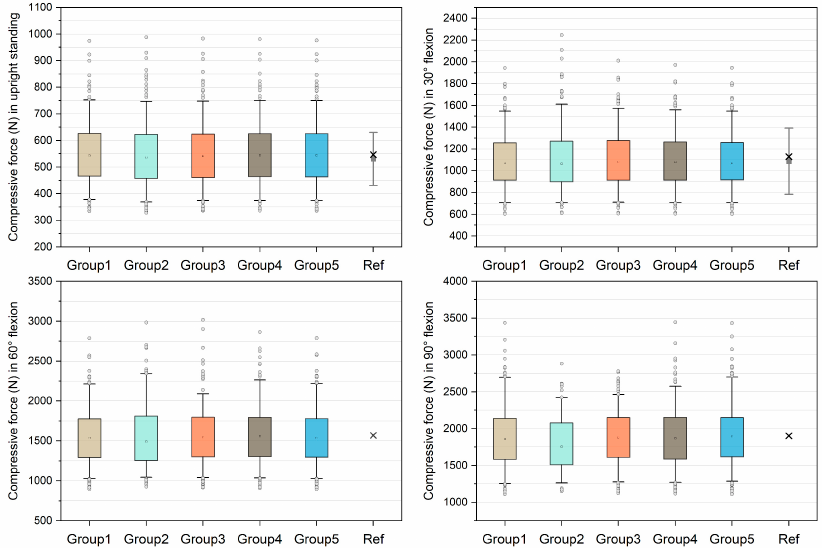
Figure 2. Unnormalized compressive forces on L4/L5 level compared with in silico and in vivo data [21,38]. The boxes represent the values between 25–75th percentiles, whereas the whiskers represent the values between 5–95th percentiles. In the reference (Ref) group, the grey squares with bars rep- resent the means and standard deviations reported by [21], and the crosses represent the values derived from [38]. Table 1. Success rate (Number of successful simulations/number of simulations performed in each group) in various trunk flexion tasks. Each group contains 250 models, and thus, 250 simulations were performed in each group. When the static optimization could find an optimal solution, it was treated as an unsuccessful simulation.